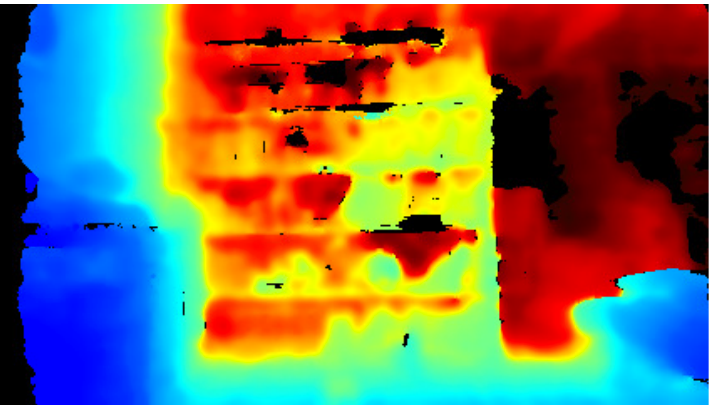
Figure 2. Color image representing depth, color red is a greater distance from the camera, blue represents a shorter distance from the